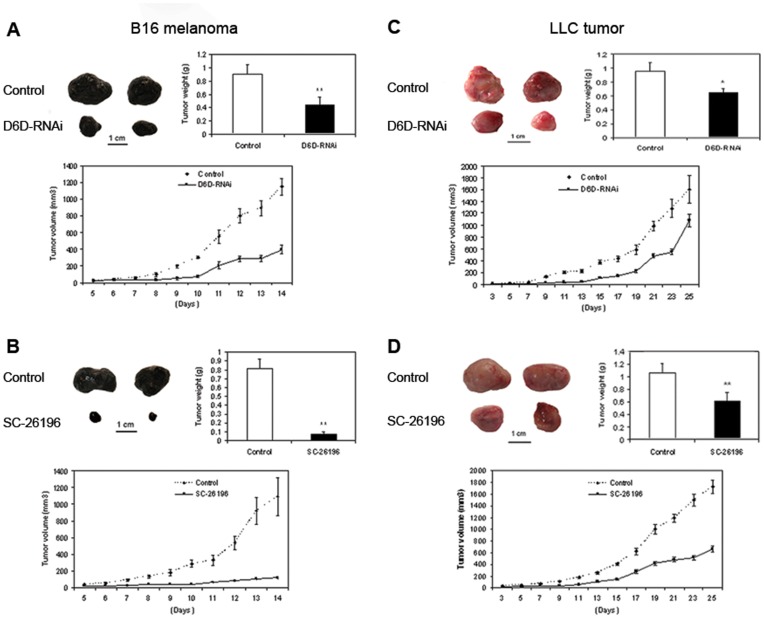
Reducing D6D expression or activity suppresses tumor growth.(a) Effect of D6D-RNAi knockdown on B16 melanoma growth. **P<0.001; n = 8 for both groups. (b) Effect of the D6D selective inhibitor SC-26196 on B16 melanoma growth. **P<0.0001; control, n = 7; treated, n = 8. (c) Effect of D6D-RNAi knockdown on LLC tumor growth. *P<0.05; n = 8 for both groups. (d) Effect of the D6D selective inhibitor SC-26196 on LLC tumor growth. **P<0.01; control, n = 7; treated, n = 10. (a–d) Upper left: Representative tumor sizes. Upper right: Average tumor weight at the end of the experiment. Lower: Tumor growth rate during the 14-day experimental period.